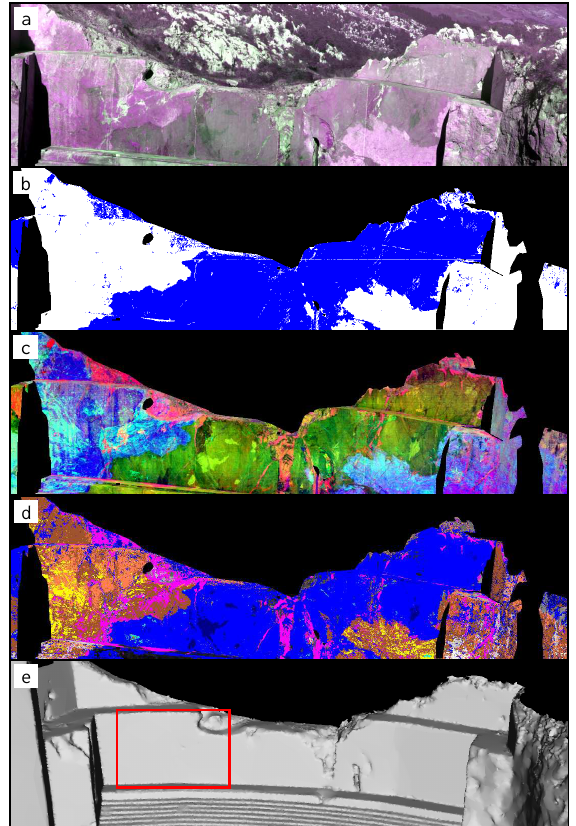
Figure 3. Hyperspectral processing results for one image of the Pozalagua Quarry. a) radiance image; b) band ratio image showing limestone (blue) and dolomite (white); c) MNF image with three bands shown in false colour; d) MTMF classification of outcrop lidar geometry of quarry face. Rectangle shows location of Fig.